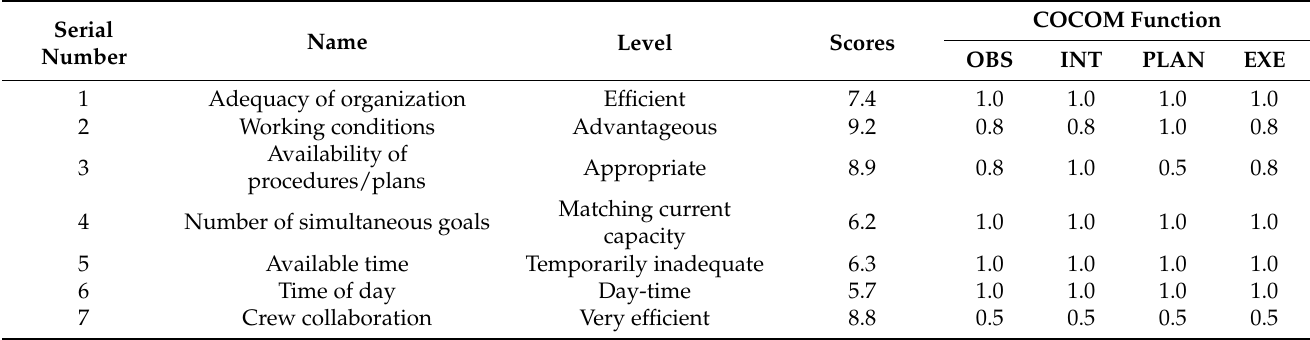
Table 11. Questionnaire summary of CPCs factors weights after layout optimization.